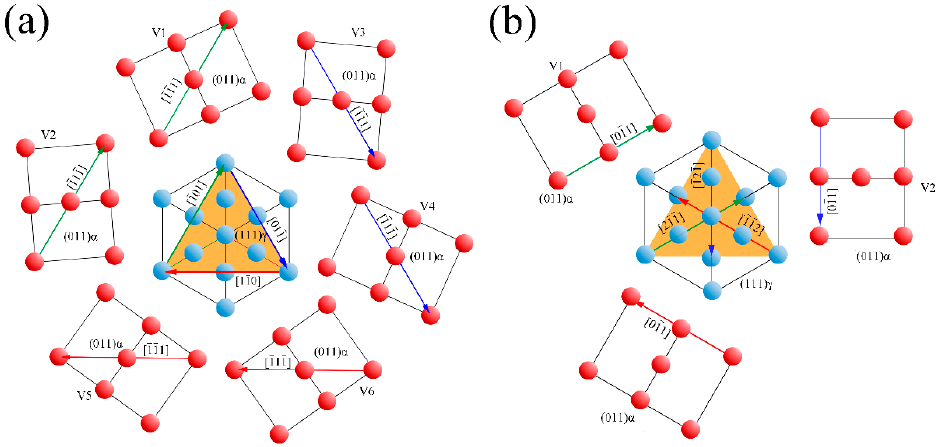
Figure 4. Illustration of the crystallographic variants evolving on the (111) austenite plane in the ( a ) K-S relationship and ( b ) N–W relationship.